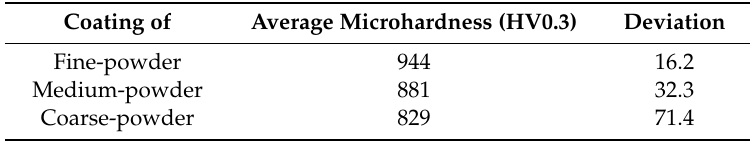
Table 3. Average microhardness measurements and associated